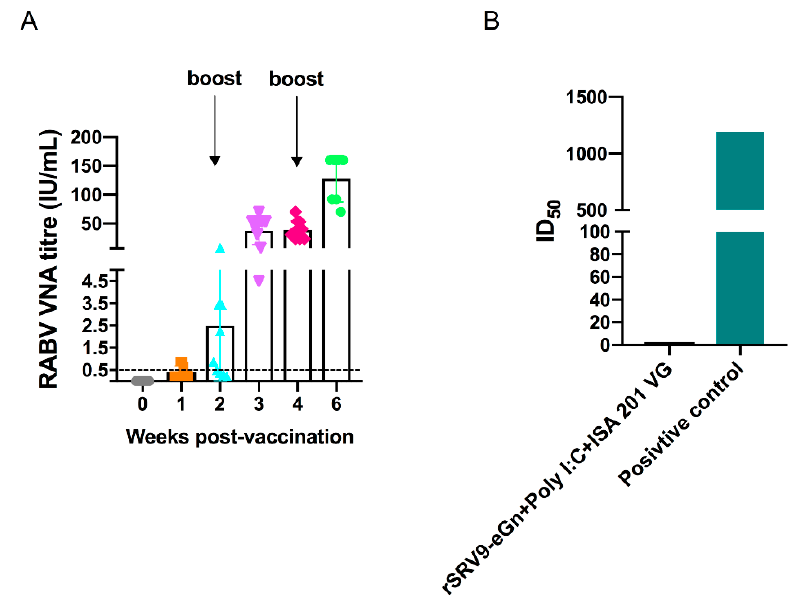
Figure 8. Virus neutralizing antibody (VNA) analysis for immunogenicity evaluation of recombinant rSRV9-eGn in mice. Serum samples collected at two weeks after the last booster immunization were analysed. The titres of VNAs specific for RABV were determined by the FAVN test and are expressed in international units (IU)/mL by using the WHO standard ( A ). The titres of anti-RVFV eGn neutralizing antibodies in immunized mice, compared to those in a positive control serum sample (anti-serum from RVFV DNA vaccine immunized guinea pig) [33], were detected with an in vitro pseudotyped VSV luciferase assay ( B ).